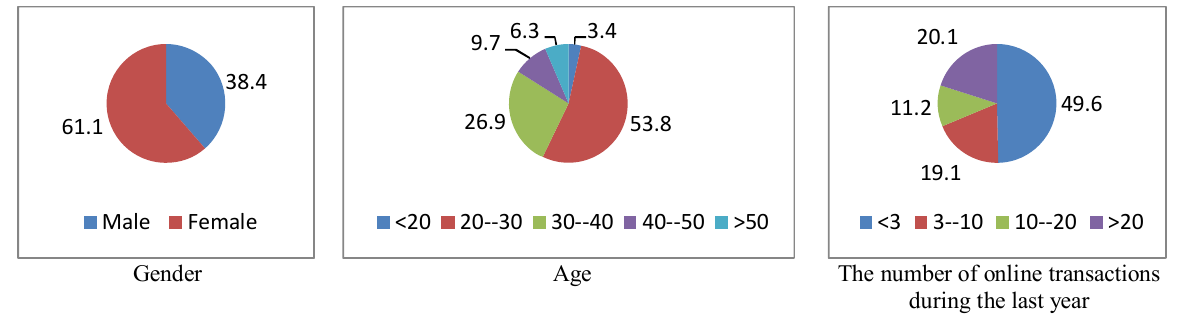
Fig. 1. Personal characteristics of the